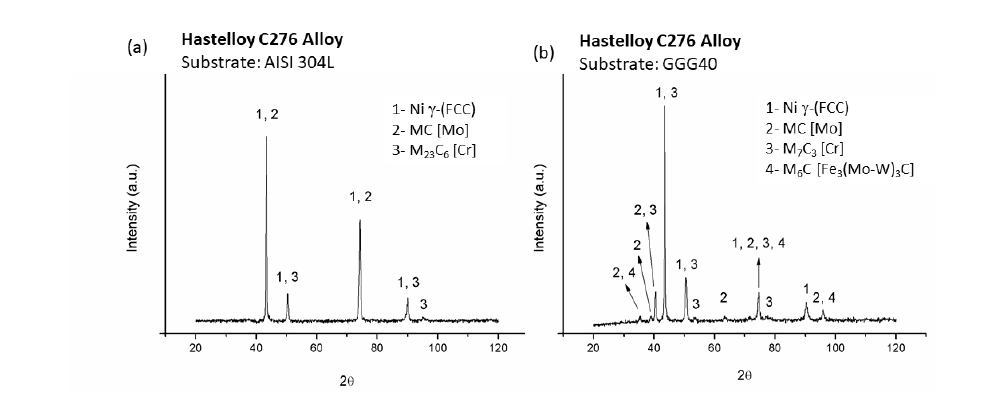
Figure 7. Typical X-ray diffractograms for coatings on: (a) AISI 304L (2.0 to 4.0 kW) and (b) AISI 304L (1.5 kW) and GGG40 (1.5 to 4.0